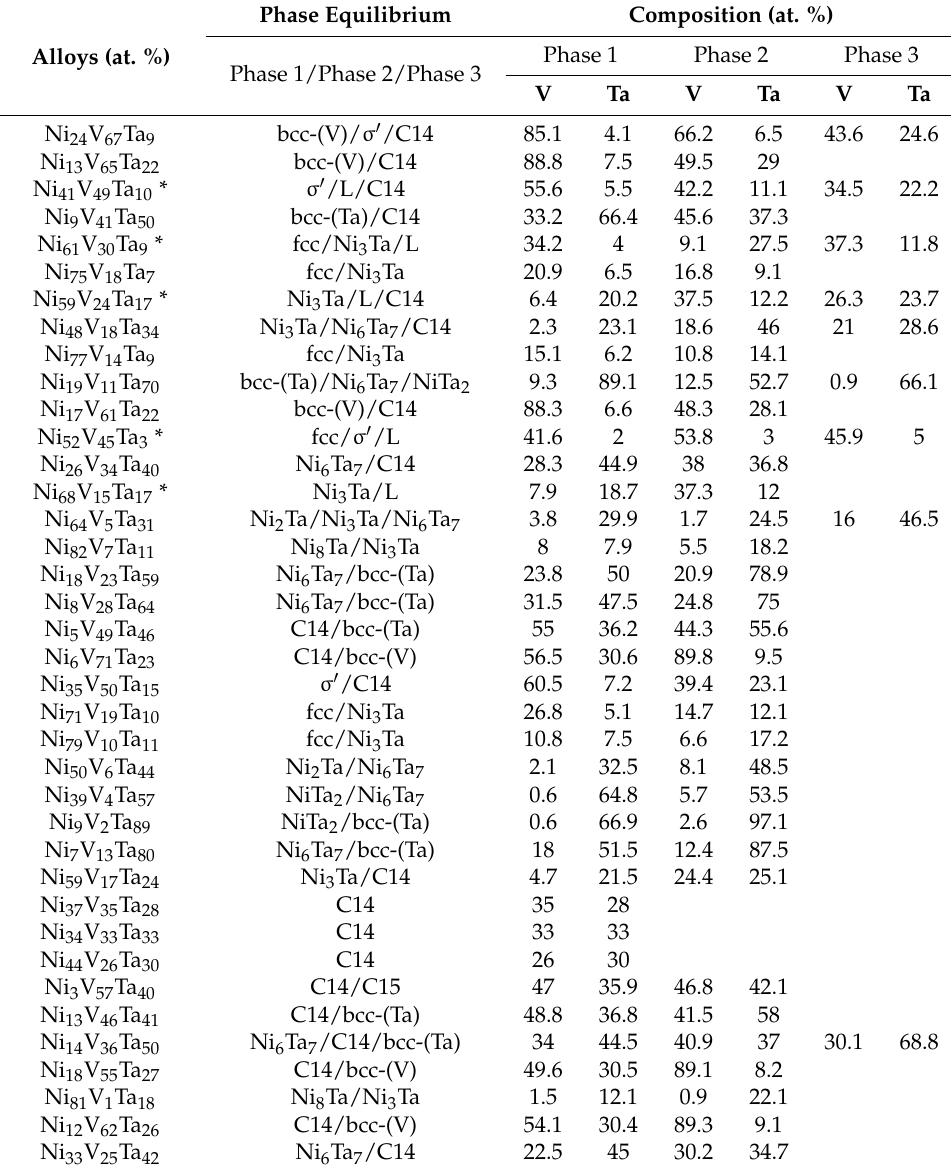
Table 3. Equilibrium compositions of the phase in the Ni-V-Ta ternary alloys annealed at 1200 ◦ C for 40 days except the starred